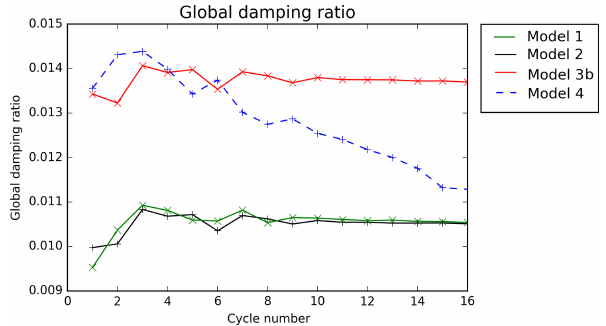
Figure 17. Global damping ratio with the different foundation mod- els.